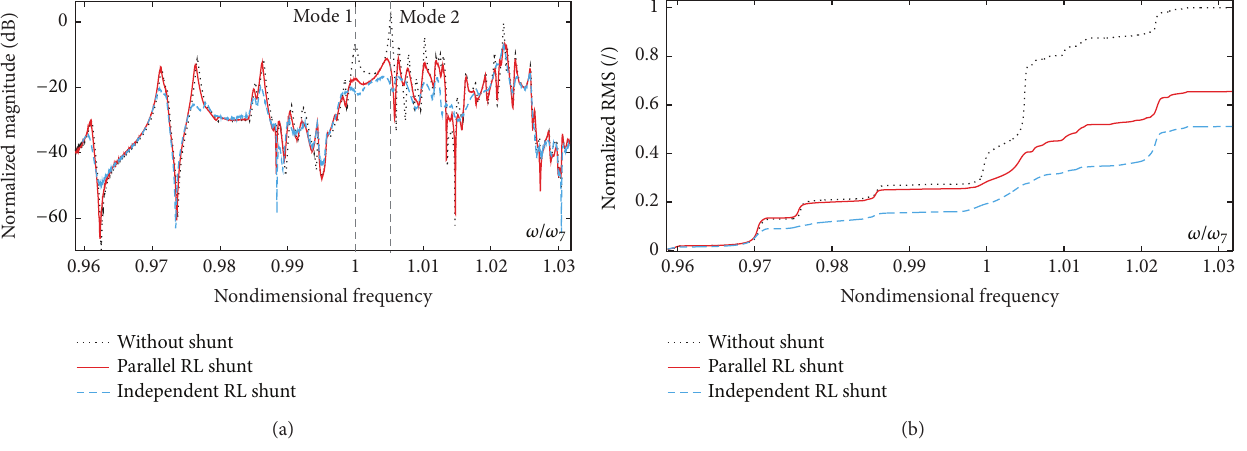
28 synthetic inductors ( 𝐿 = 0.7 H), and (iii) the 28